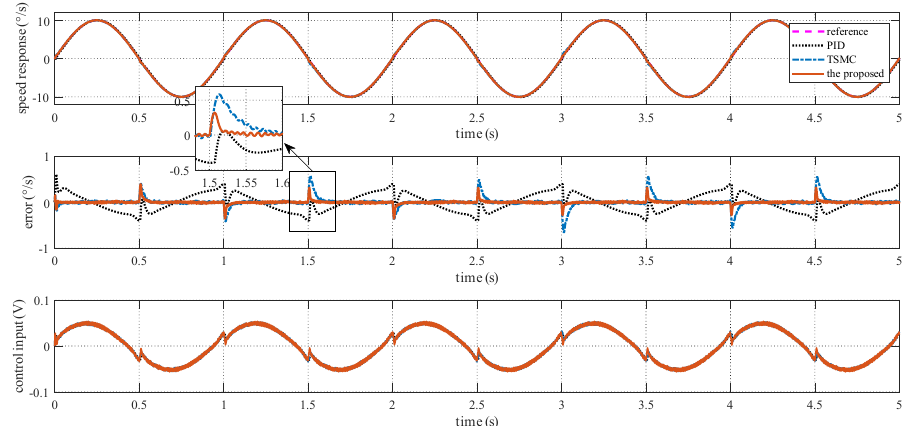
Figure 4. Simulation response curves to a sinusoidal reference signal with 10 ◦ /s amplitude and 1 Hz frequency.